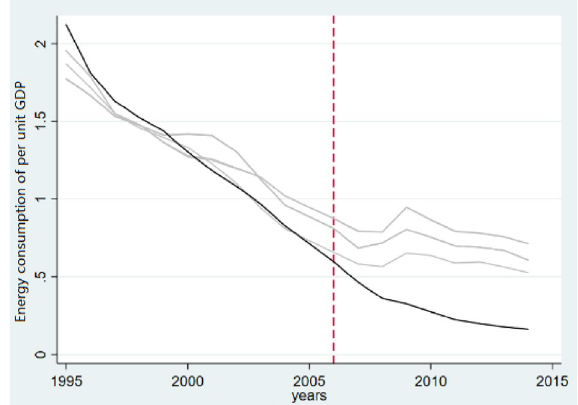
Figure 3. Sensitivity test of energy consumption per unit GDP.